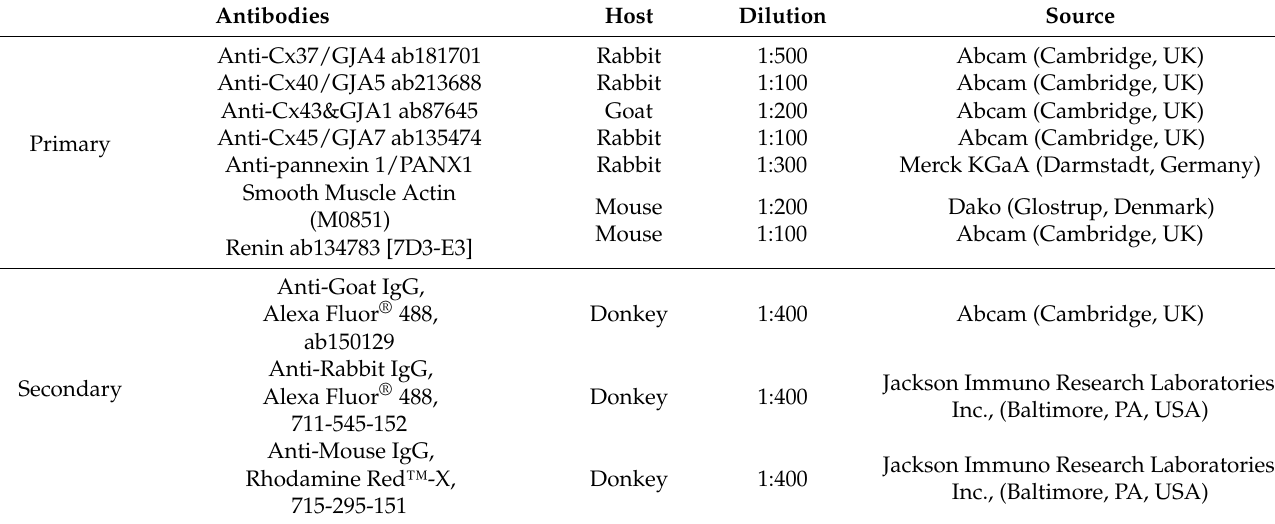
Table 2. Antibodies used for